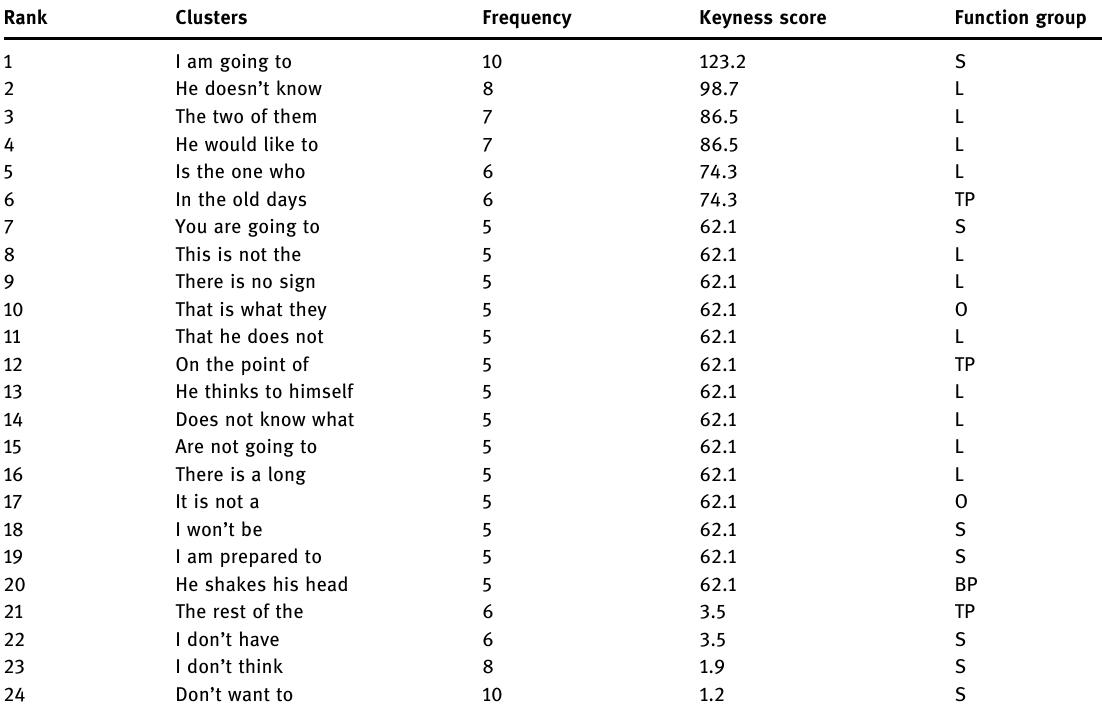
Table 5: Four - word clusters in DS